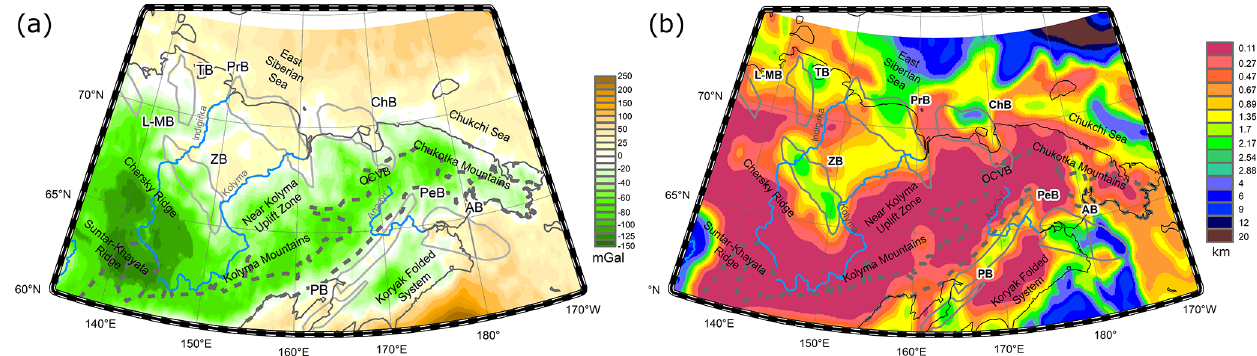
Figure 2. (a) Initial Bouguer gravity data. (b) Thickness of sediments according to the initial